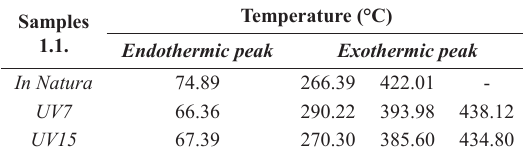
Table 3. Characteristic temperature of weight loss.